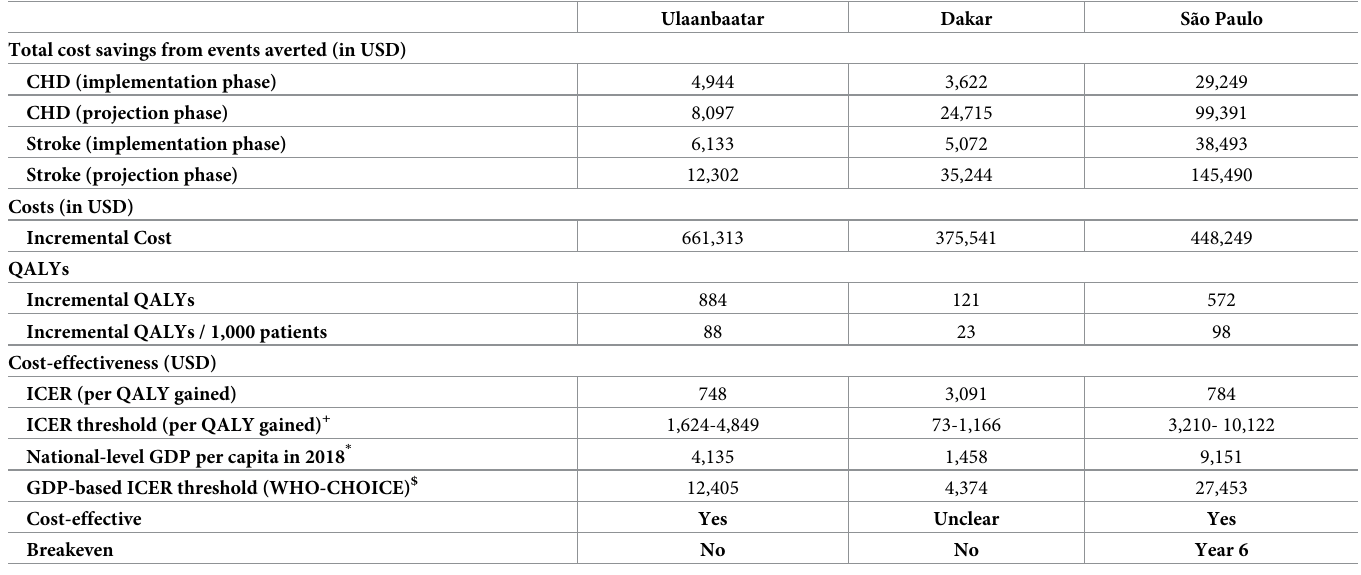
Table 5. The incremental cost summarizes the difference in total costs (program cost and CV-event costs) for the No CARDIO vs CARDIO scenario. + Estimates extracted from [40]. The thresholds are adjusted for PPP and in-country opportunity costs. * Estimates extracted from [43]. $ WHO CHOICE stipulates a cost-effectiveness threshold of three times the per-capita